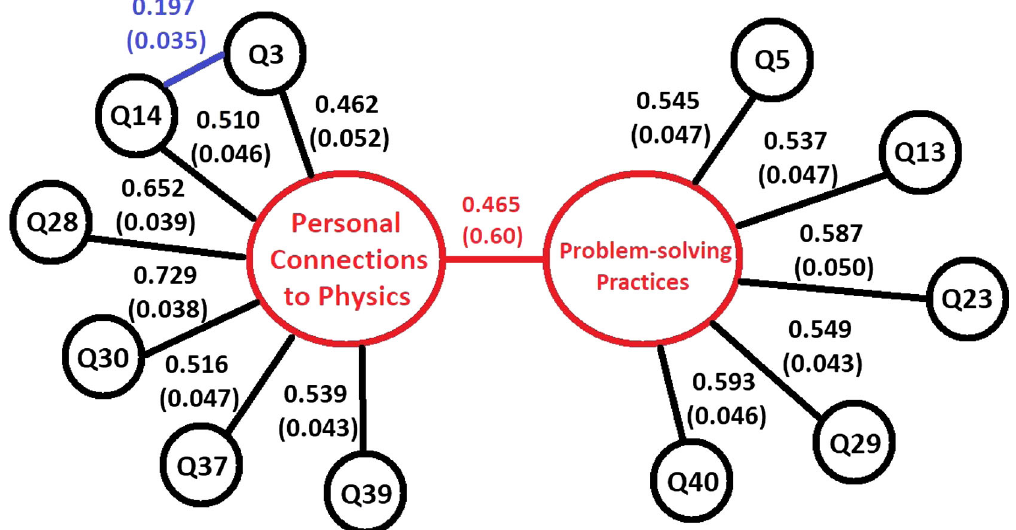
FIG. 2. Standardized factor loadings and correlations for the final model. Black numbers represent factor loadings; red numbers represent interfactor correlations; blue numbers represent interitem correlations; numbers in parentheses represent standard errors.